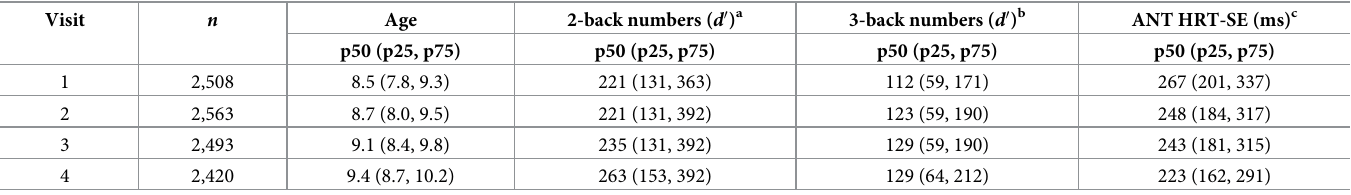
Table 1. Median (percentiles 25 and 75) of children’s age and cognitive outcomes (working memory and inattentiveness) at each of the 4 repeated visits. Visit